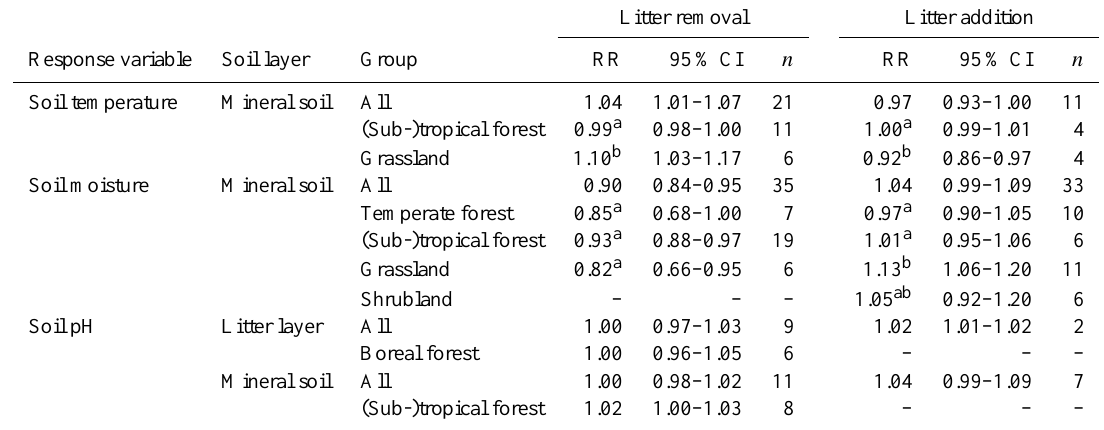
Table 1. Effects of litter removal and litter addition on soil physicochemical properties of different ecosystems. For each response variables, the responses of the ecosystems denoted by different superscript letter differed significantly ( P < 0 . 05). RR: the mean response ratio; 95% CI: 95% confident intervals; n: no. observations; “–”: no